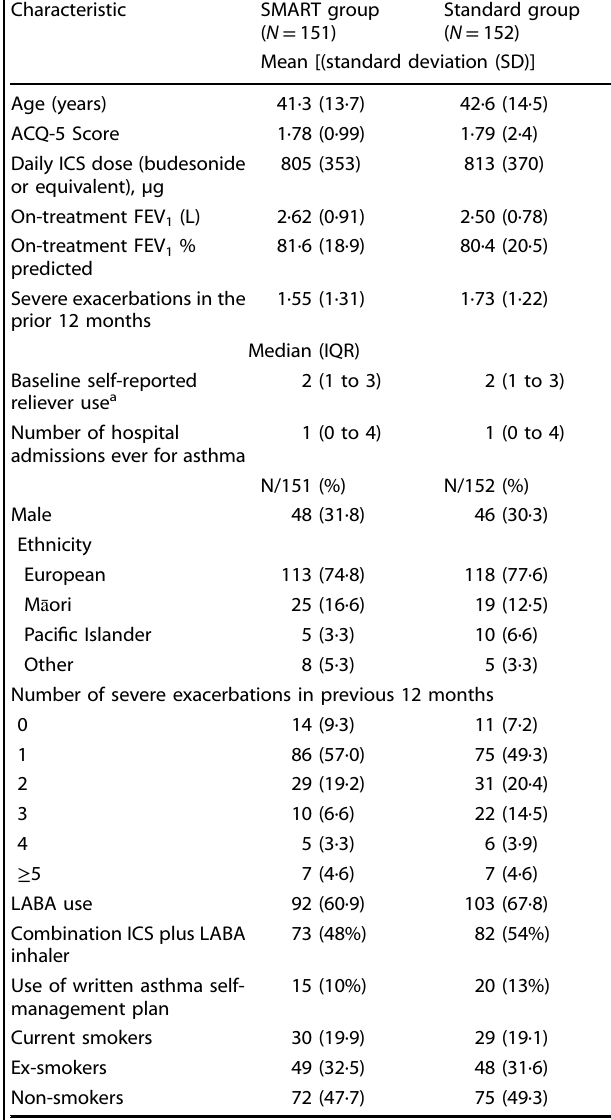
Table 1. Participant